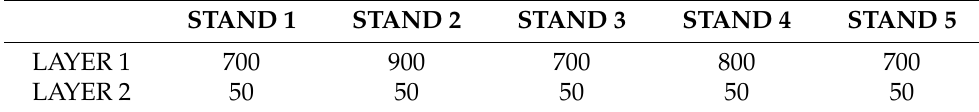
Table 9. The numbers of hidden nodes for each layer for the motor load prediction model.